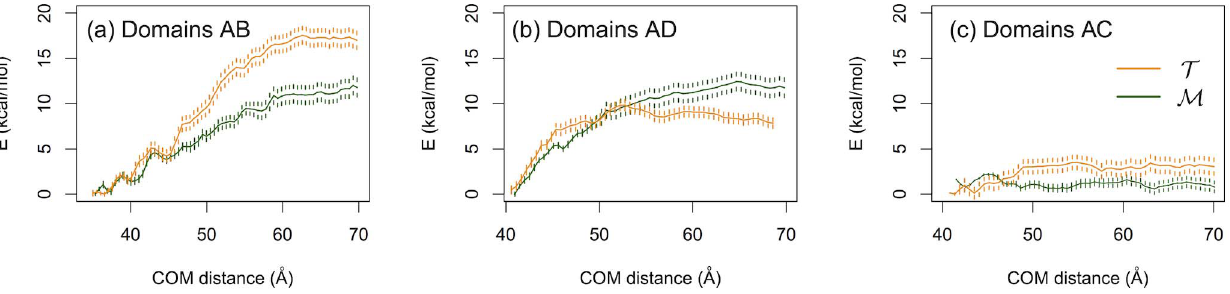
Figure 6. Potential of mean force profiles of domain separation. (a) Separation of domain A from B (see also Fig. 1), (b) Separation of domain A from D and (c) Separation of domain A from